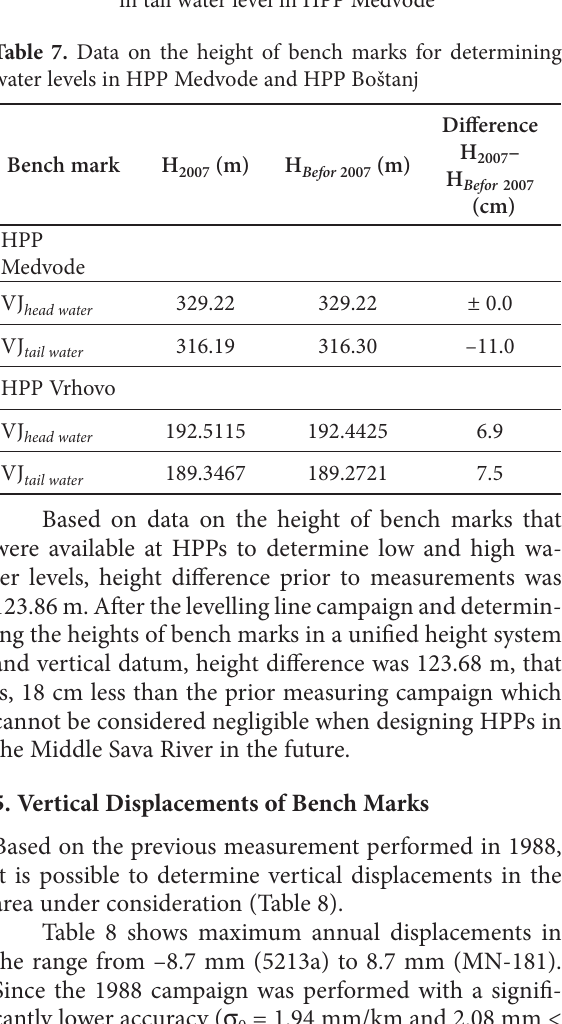
Fig. 2. Data on altitude and height difference